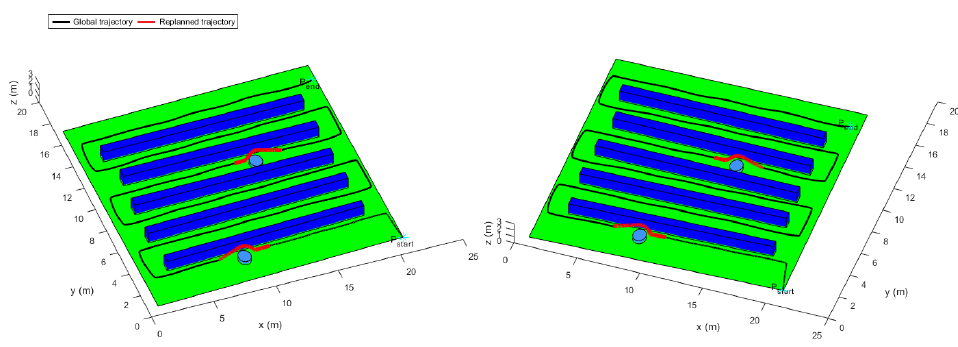
Figure 19. The global position and the replanned